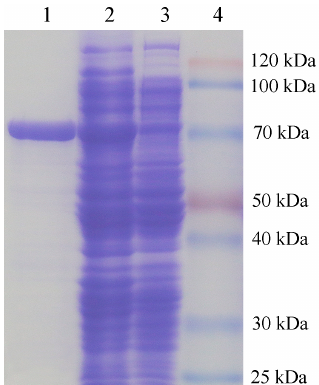
Figure 4. 10% sodium dodecyl sulfate polyacrylamide gel electropheresis (SDS-PAGE) analysis of AgaML. ( 1 ) Purified AgaML; ( 2 ) Recombinant Escherichia coli BL21(DE3) cells harboring pET- AgaML after induced; ( 3 ) Uninduced recombinant Escherichia coli BL21(DE3) cells harboring pET- AgaML ; and ( 4 ) Protein marker.